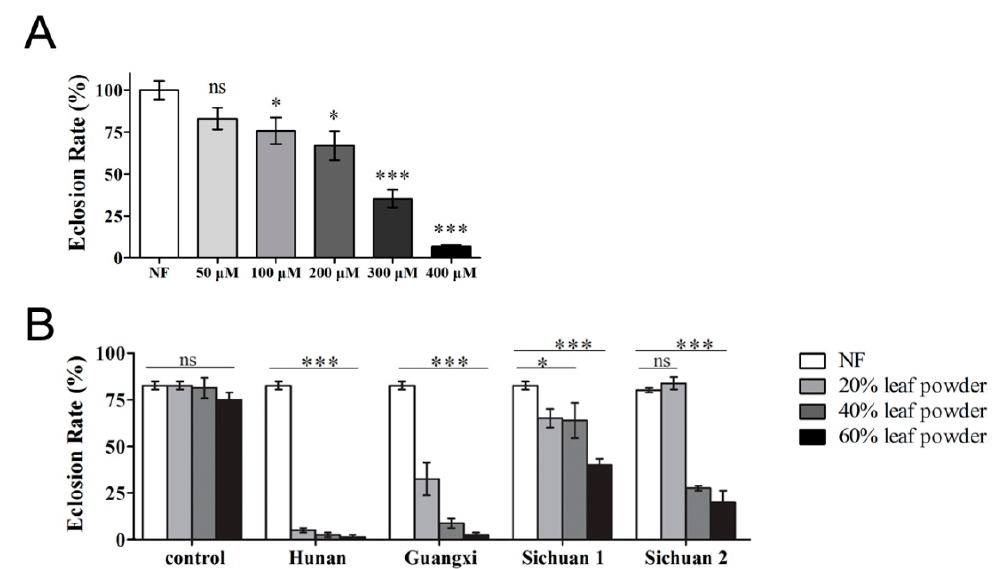
Figure 2. Elevated temperatures exacerbated the effect of ART on the flies. ( A ) A dramatic decrease in eclosion rate at 29 °C, a mere increase of 4 degrees, was observed when flies were treated with ART. ( B ) Powdered leaves of A. annua from different regions exhibited similar, albeit various, levels of inhibitory effects on flies. Food was prepared from the standard corn meal mixed with the leaf powders. The eclosion rate was assayed at 29 °C. Data are presented as mean ± SEM; n ≥ 5. *** p < 0.001, * p < 0.05. ns, no significance.